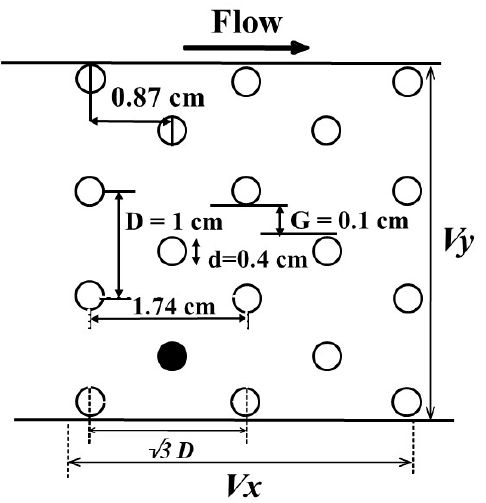
Figure 3. ( a , b ) Schematic diagram of the numerical domain, along with specific locations for cases 1–2 and 3–4, respectively.